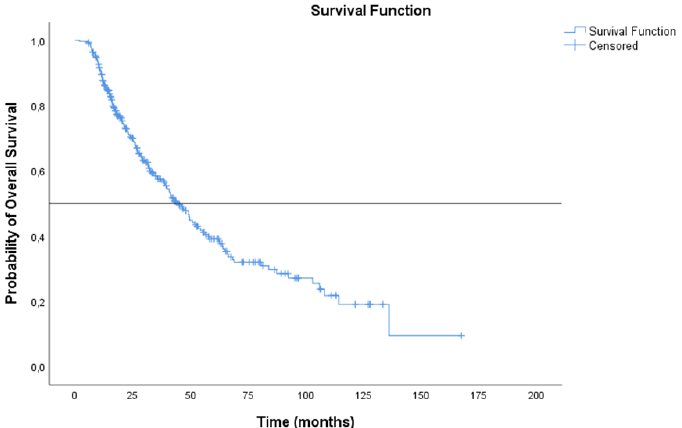
Figure 5. Kaplan–Meier curve of estimated overall survival in the intention-to-treat population.